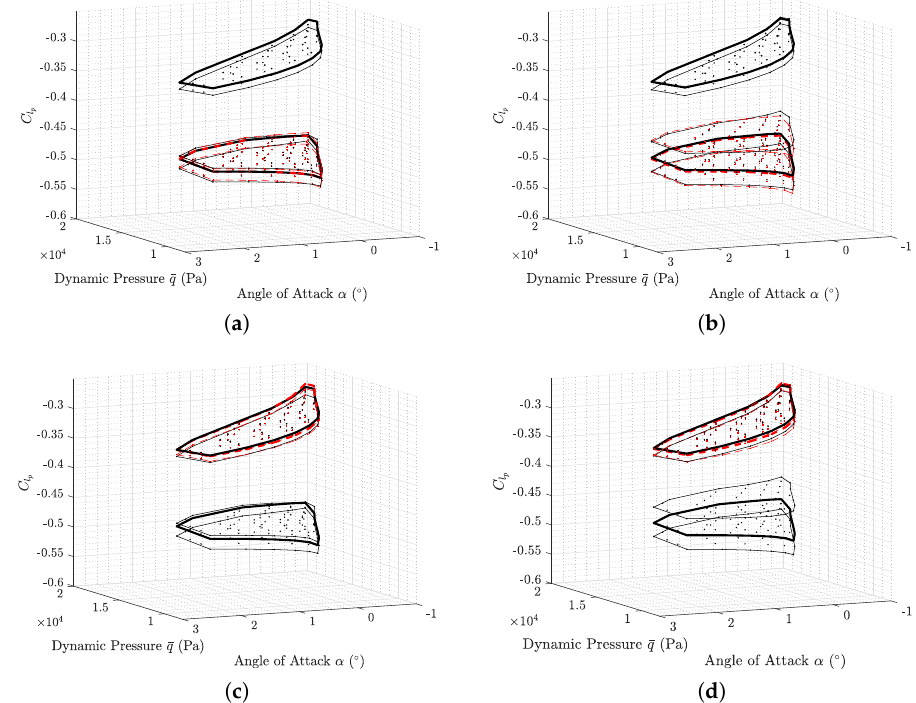
Figure 12. Roll damping model (black: identified model, red: prediction model): ( a ) rigid model 10% wingtip; ( b ) rigid model 20% wingtip; ( c ) flexible model 10% wingtip; and ( d ) flexible model 20% wingtip.